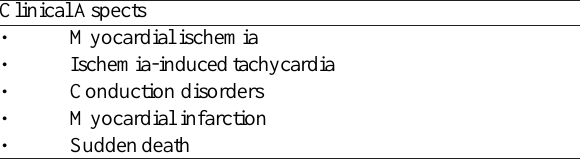
Table 1. Main clinical aspects.